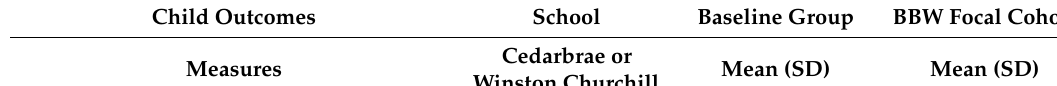
Table 2. Comparison of Baseline and BBW Focal Cohort Samples on Child